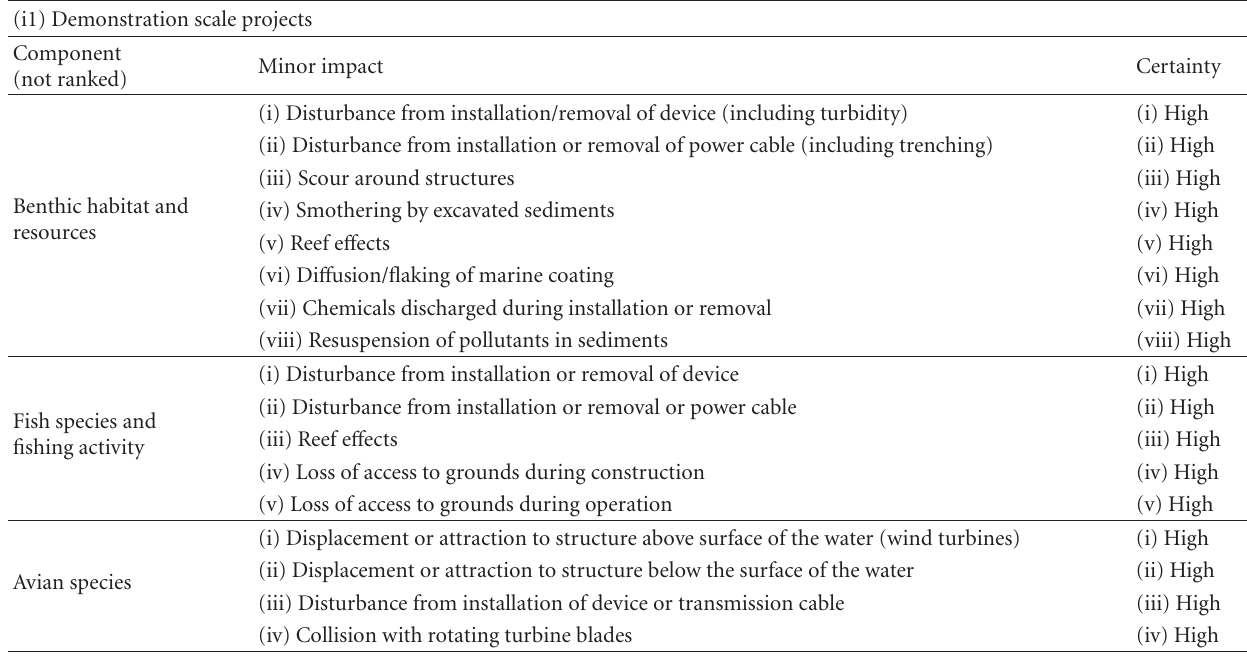
Table 3: A description of the potential impacts resulting from demonstration scale projects. See text, Section 3.3, for a narrative summary of this development scenario. Minor impacts are listed in the order they appear in the renewable energy impact